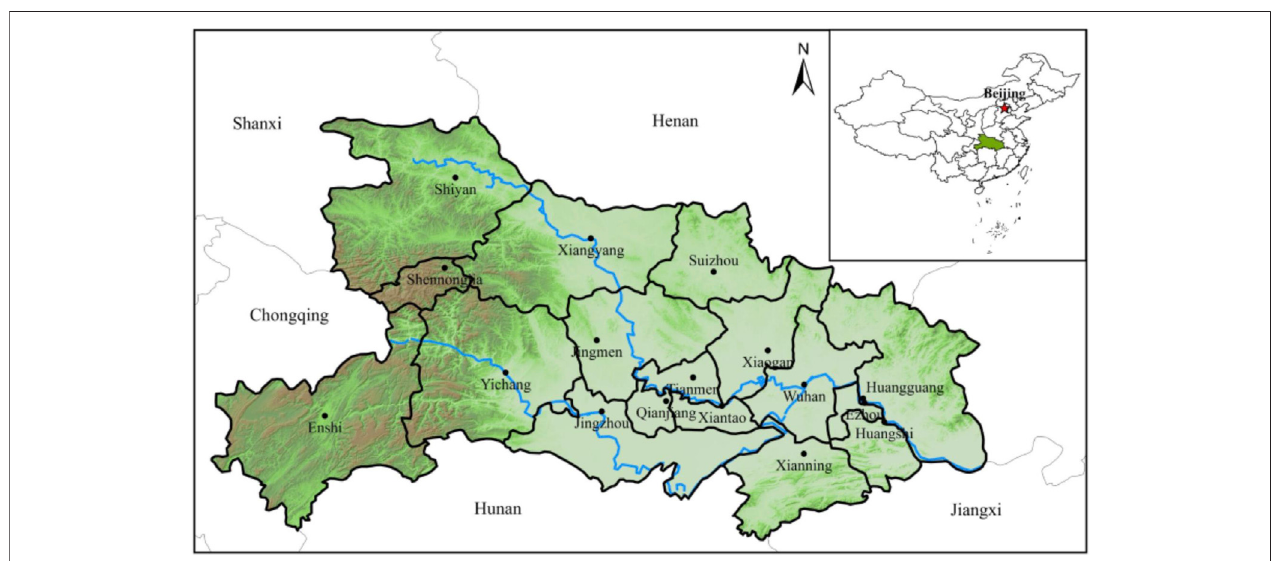
FIGURE 1 | Study area